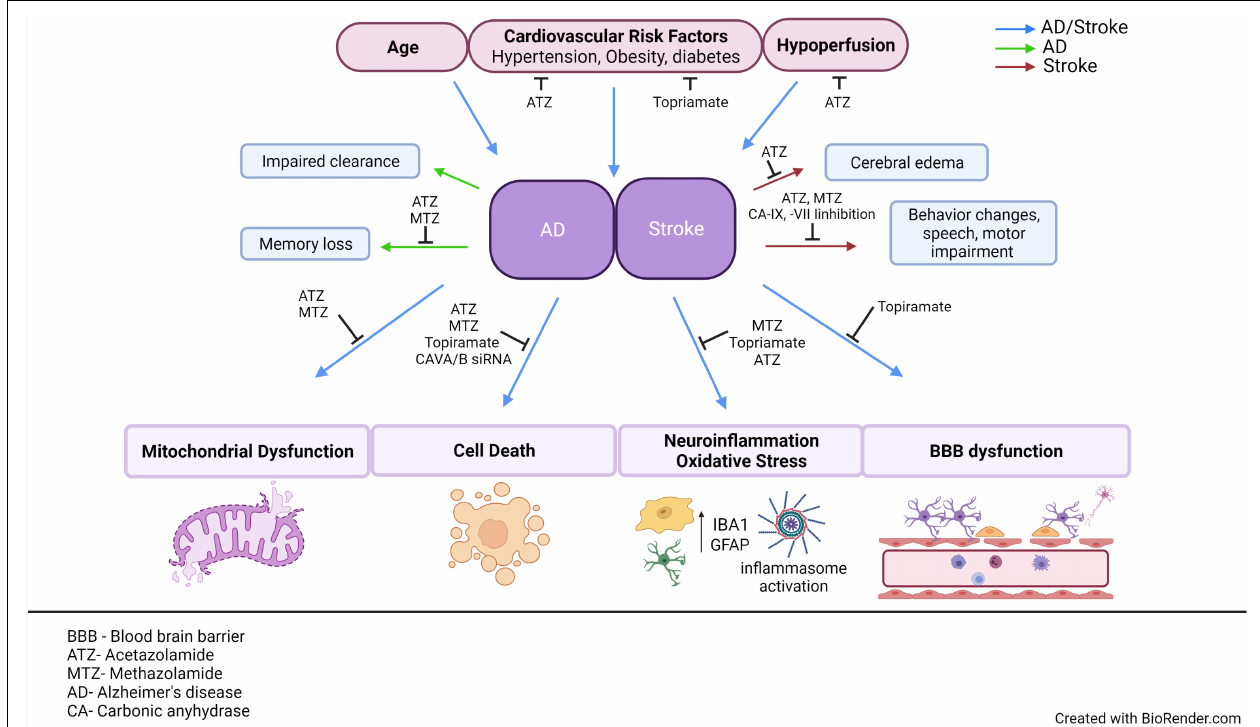
FIGURE 2 | AD and stroke share common risk factors and pathological mechanisms. This figure aims to emphasize the multiple CAIs, as well as point out specific CA isoforms that have been observed to modulate cerebrovascular pathology in models of AD or stroke. Age, cardiovascular risk factors and hypoperfusion are all common risk factors between AD and stroke. Both AD and stroke exhibit NVU dysfunction, accompanied by many common molecular mechanisms, such as mitochondrial dysfunction, vascular, and neuronal cell death, neuroinflammation, and BBB dysfunction. If these mechanisms are causes or effects of neurovascular dysfunction is still a hotly debated issue. Despite the differences in the advanced pathological manifestations of the two diseases, stroke does increase the risk of dementia, suggesting that targeting their common risk factors and molecular mechanisms could ultimately mitigate the development of cerebrovascular pathology in both disorders, protecting brain health and CNS homeostasis. ATZ, Acetazolamide; MTZ, methazolamide; BBB, blood brain barrier; NVU, neurovascular unit; CNS, central nervous system; CA, carbonic anhydrase; AD, Alzheimer’s disease; CAIs, carbonic anhydrase inhibitors. This figure was created with BioRender.com.